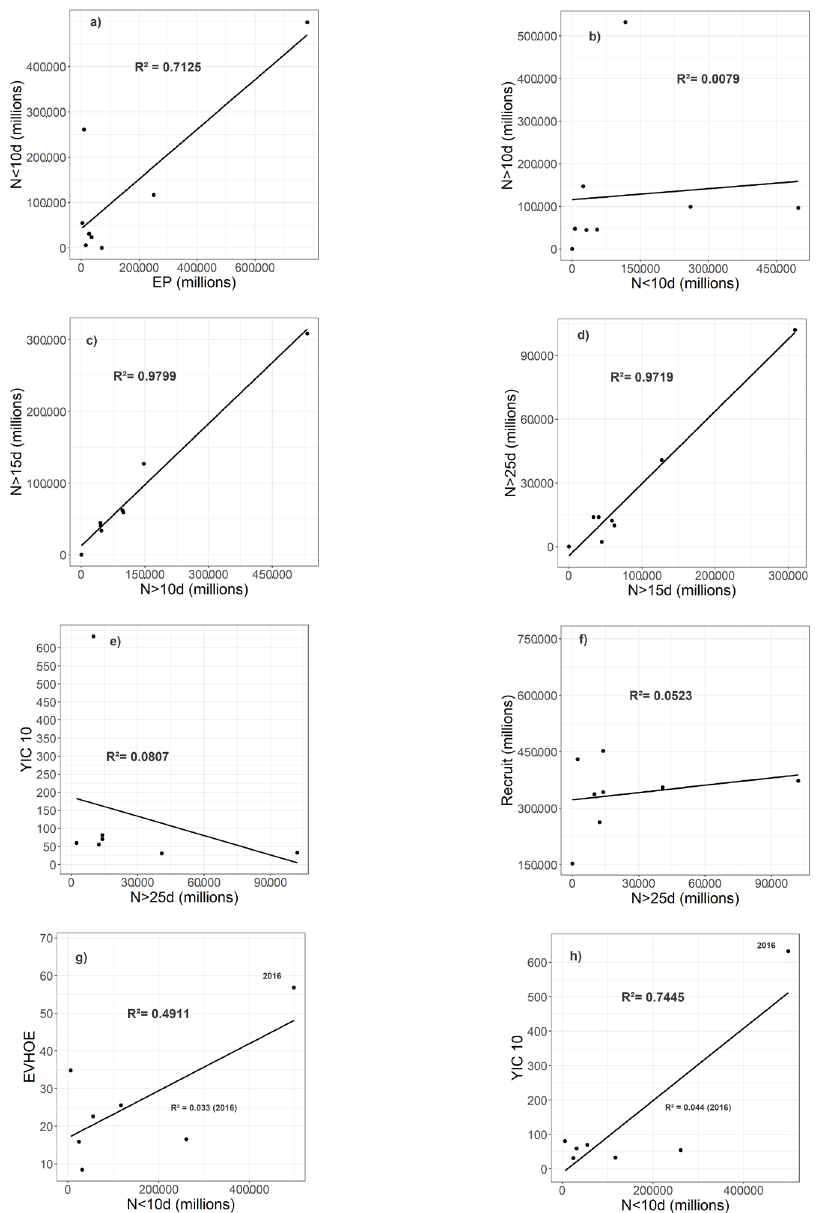
Figure 4. Correlation between ( a ) egg production (EP) and yolk-sac larvae (N < 10); ( b ) yolk-sac larvae (N < 10) and the other larvae stages (N > 10); ( c ) N> 15 vs. N > 10; ( d ) N > 25 vs. N > 15; ( d ) YCI 10 vs. N > 25; ( e ) YCI10; ( f ) recruits vs. N > 25; ( g ) EVHOE juveniles index vs. N < 10; and ( h ) YCI10 vs. N > 10. N >10: Abundance of larvae more than 10 days old; N > 15: Abundance of larvae more than 15 days old; N > 25: Abundance of larvae more than 25 days old; YCI10: Abundance of juveniles smaller than 10 cm (EVHOE surveys); and Recruit: SS3-derived age-0 recruitment [37]. In ( g , h ), the two R 2 values correspond to the estimate with all data (R 2 = 0.49 and 0.74) and without 2016 (R 2 = 0.03 and 0.04),